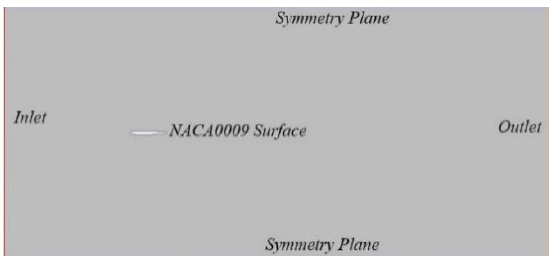
Figure 1. Diagram of the hydrofoil model. Figure 2. Computational domain. Figure 2. Computational domain.